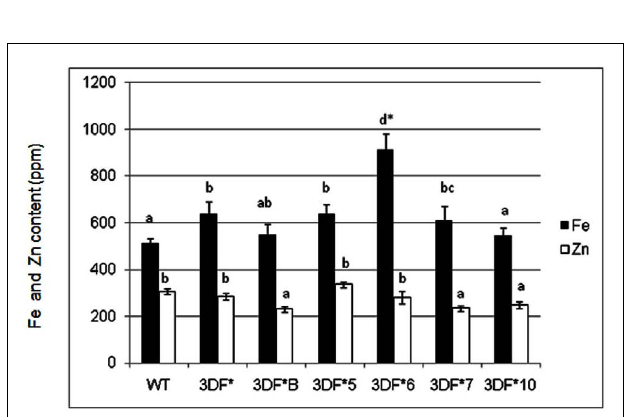
FIGURE 1 | Confirmation of cassava transformants with modified FEA1 gene. (A) PCR amplification of the FEA1 gene in transgenic cassava.WT, wild-type cassava; 3DF*, 3DF*B, 3DF*5, 3DF*6, 3DF*7, and 3DF*10 are transgenic cassava. (B) Analysis of FEA1 gene expression: (A) RT-PCR